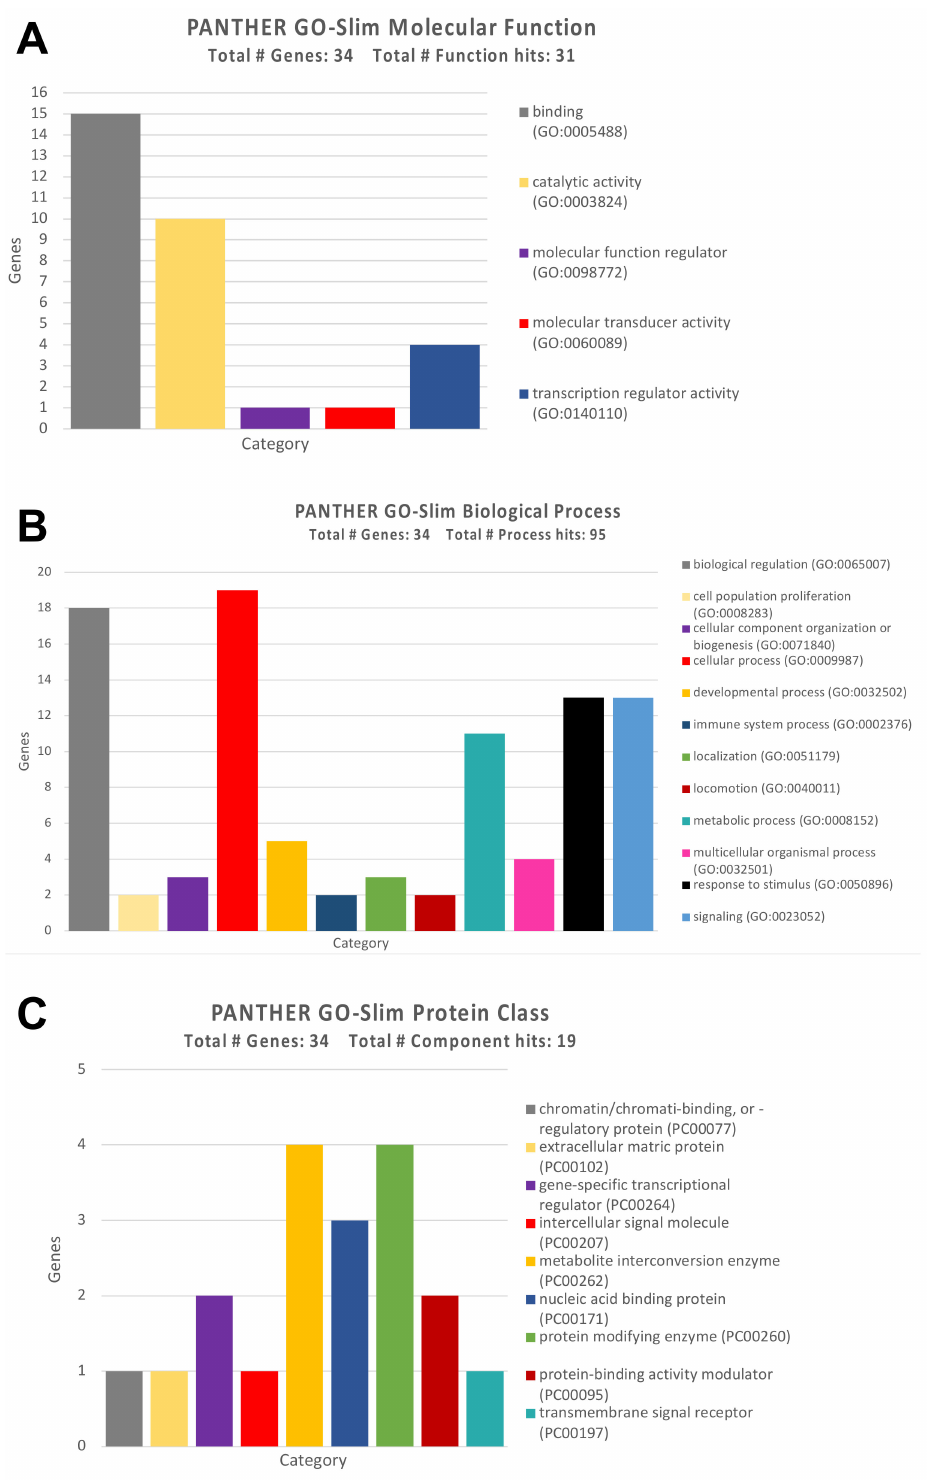
Figure 6. ( A ) GO Panther analysis of the molecular functions performed by the genes modulated by the identified miRNAs; ( B ) GO Panther analysis of biological processes in which the genes modulated by the identified miRNAs are involved; ( C ) GO Panther analysis of the protein classes of the genes modulated by the identified